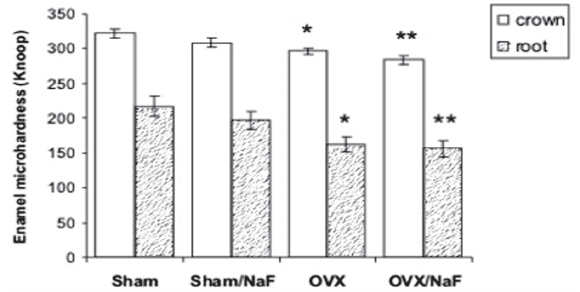
FIGURE 1- Enamel microhardness of the maxillary incisor of sham and OVX female rats treated with fluoride (sham and OVX/NaF) or distilled water (sham and OVX). *P<0.05 vs sham; **P<0.05 vs sham/NaF; n=44